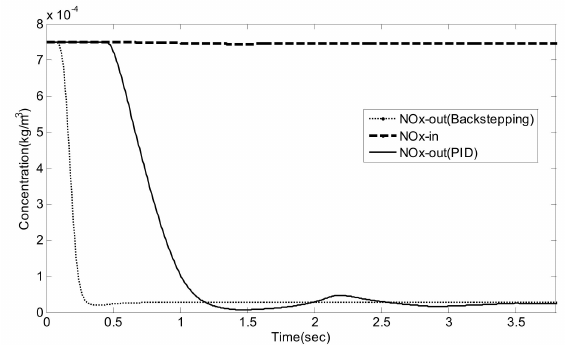
Figure 16. NO / NO 2 = 2 / 1, NOx concentration before and after the SCR system.